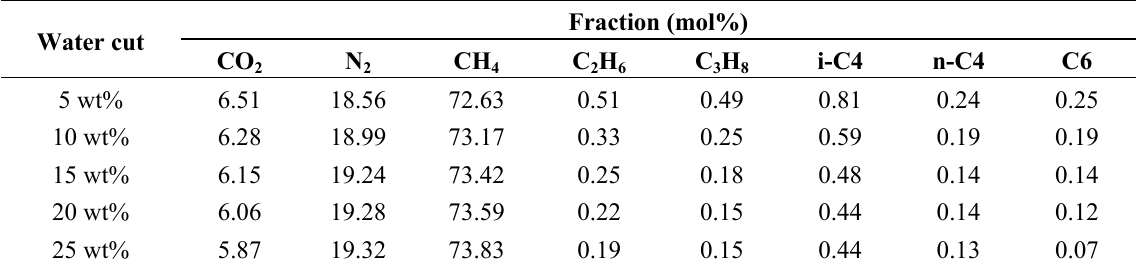
Table 3. Composition of equilibrium gases at different water cuts.